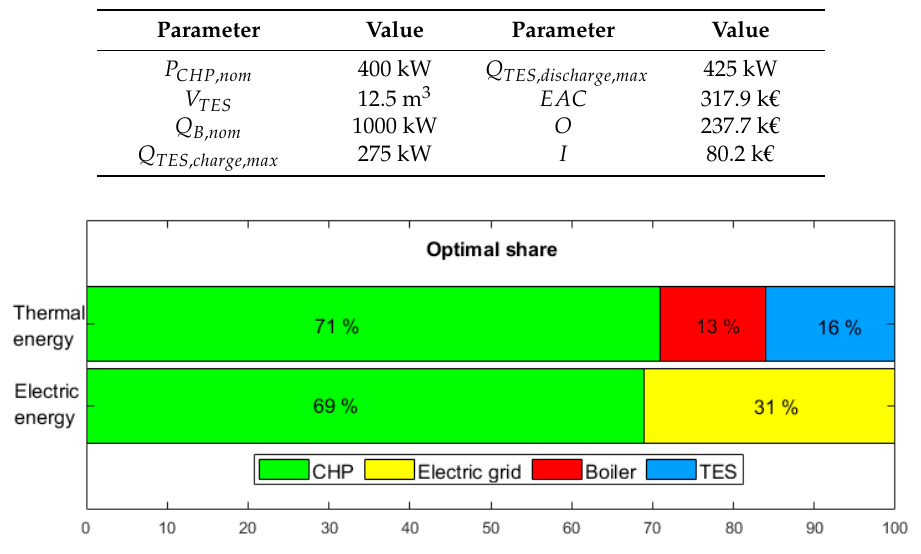
Figure 7. Optimal electric and thermal load sharing.